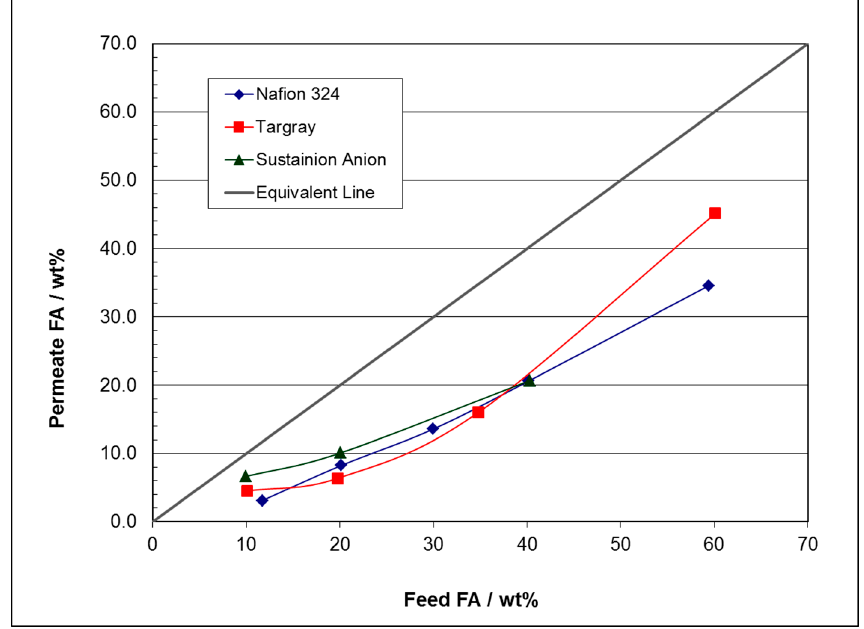
Figure 5. Comparison plot of the wt% FA in the permeate versus the FA wt% in the feed for the Nafion ® N324, Targray, and Sustainion ® membranes at an operating temperature of 60 °C.